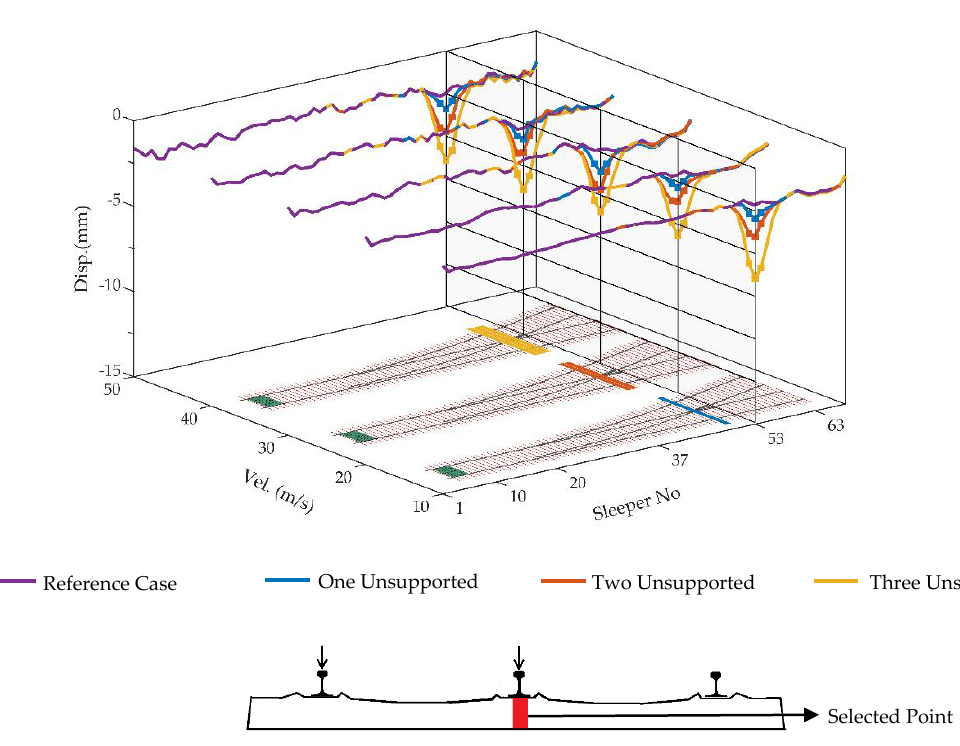
Figure 6. The maximum displacement of bearers at rail seats when an unsupported bearer exists at closure panel.